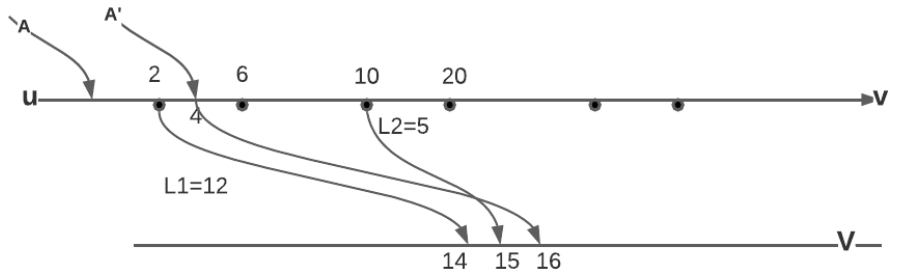
Figure 9. Example of departure in next intervals.